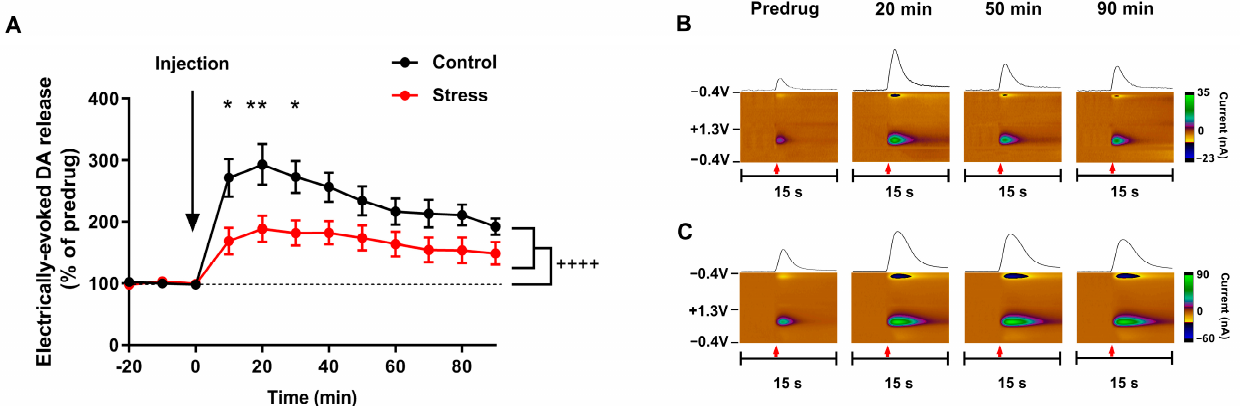
Figure 6. Raclopride (2 mg/kg) had a significantly reduced effect on electrically evoked accumbal